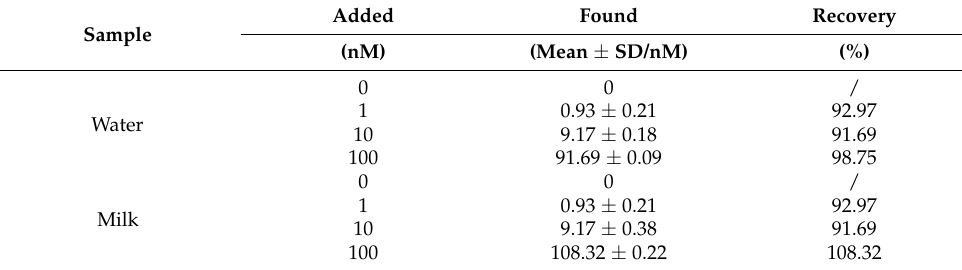
Table 1. Determination of sulfamethizole (SMZ) in real samples ( n = 3).